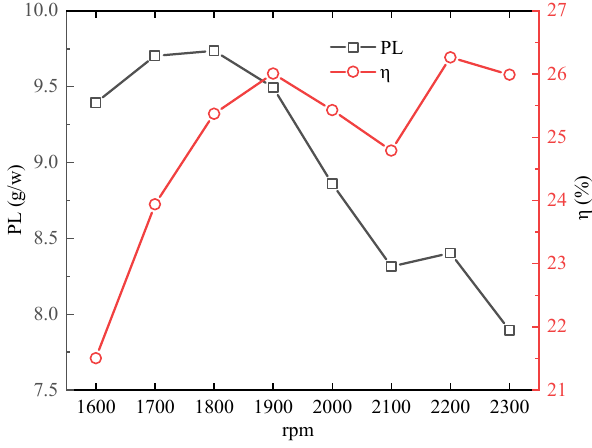
Figure 8. PL variation.